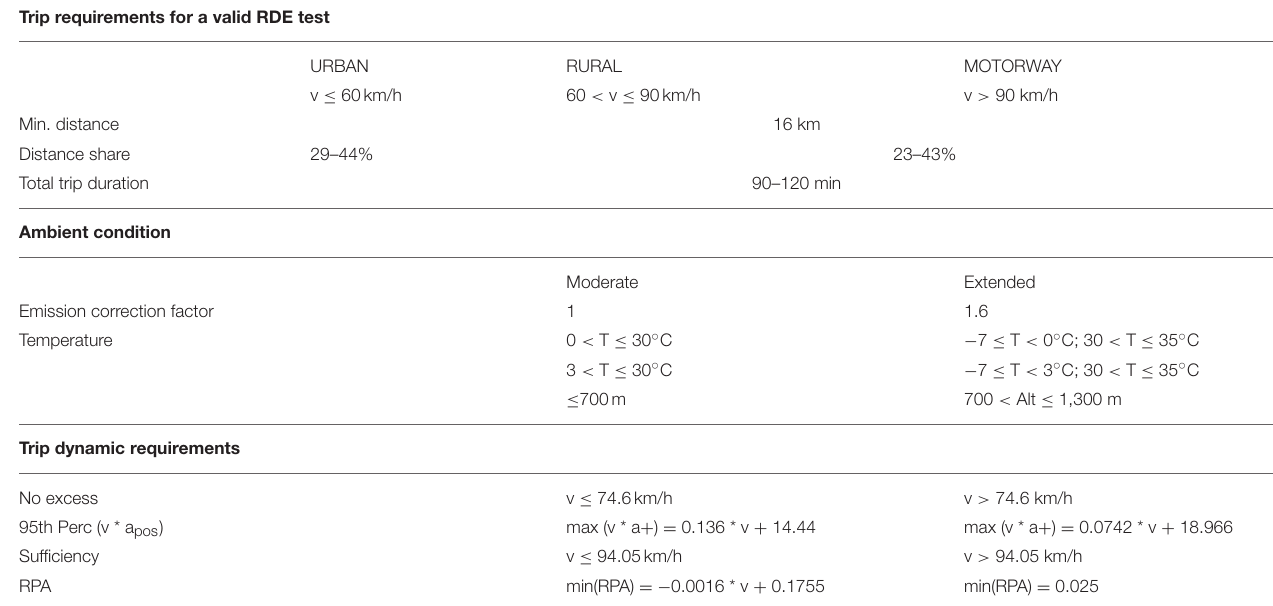
TABLE 3 | Some boundary conditions for a valid RDE test (Commission, 2017).